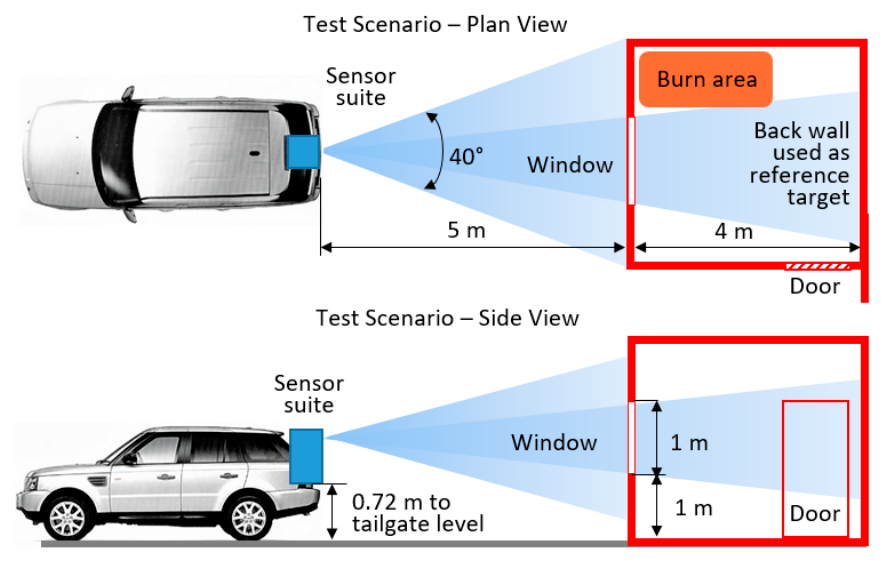
Figure 1. Test scenario.